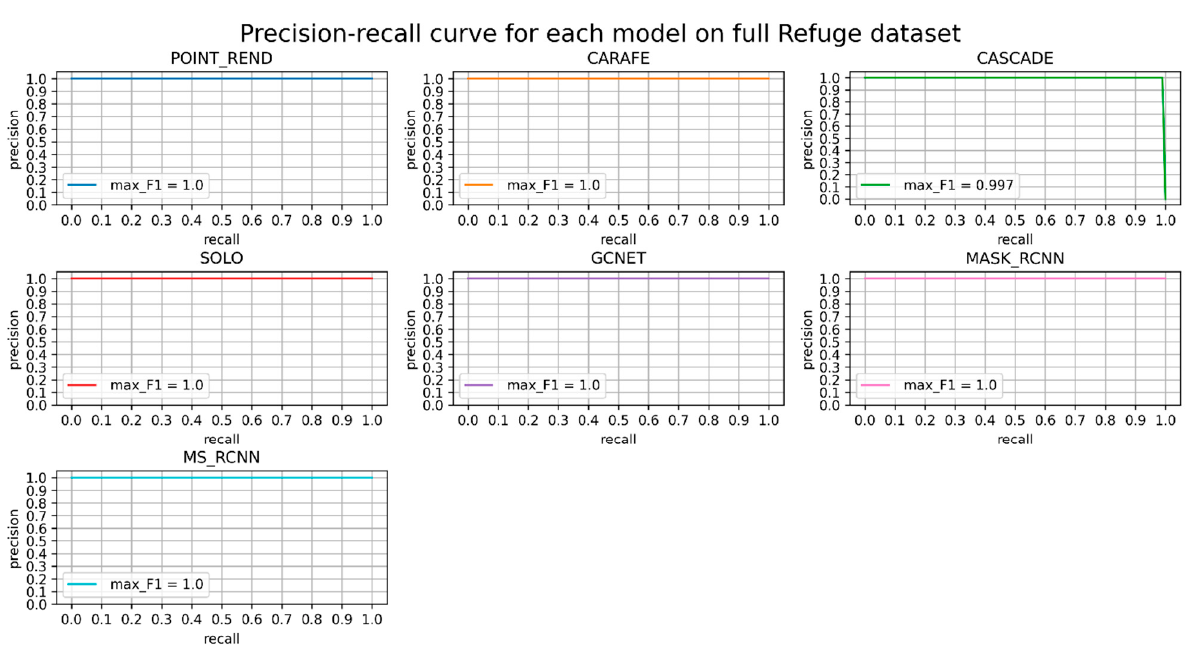
Figure 6. Precision-recall curve for each model on full Refuge dataset. F1 score is provided for each model.